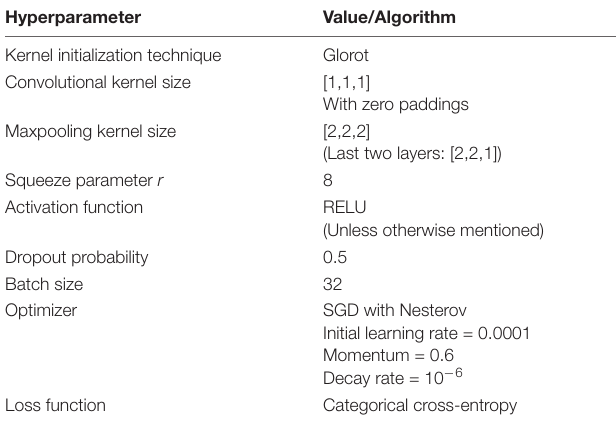
TABLE 2 | The model and training’s main